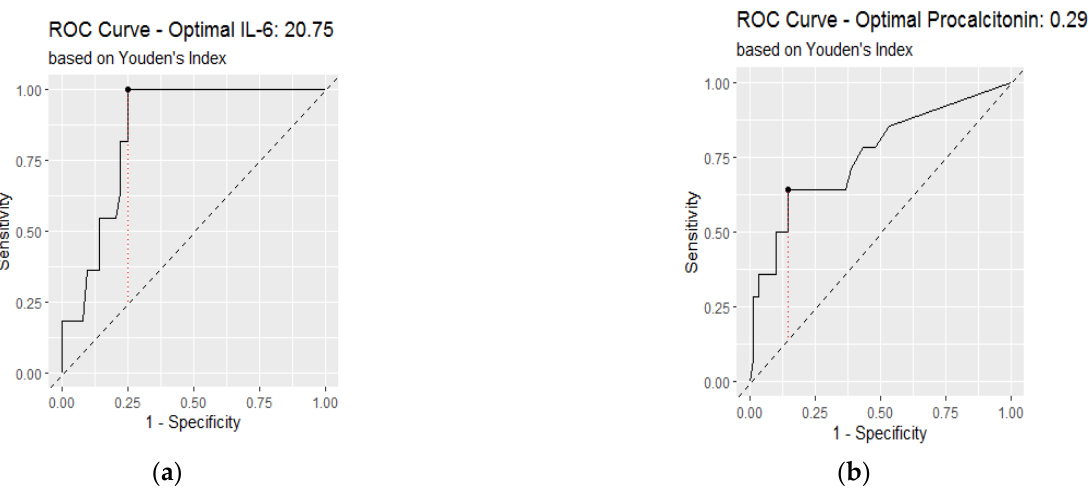
Figure 5. Receiver operating characteristic curve analysis to assess the diagnostic value of inflammatory biomarkers for lung involvement over 50%: ( a ) C-reactive protein; ( b ) neutrophil to lymphocyte ratio.